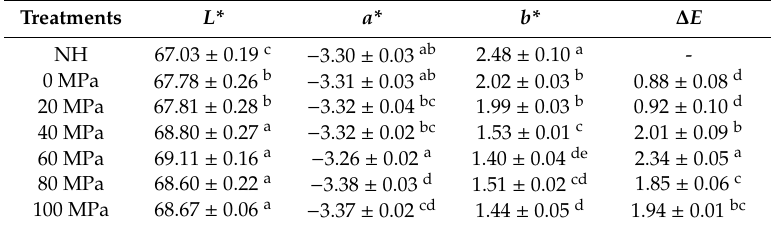
Figure 7. HPH processing decreased the shear stress ( σ ) of the pulps in relation to each shear rate ( γ ). As expected, the lily pulps’ flow behavior was well fitted to the Hershel–Bulkley rheological model ( R 2 > 0.995), and the parameters obtained for this model are summarized in Table 4. The NH and homogenized pulps exhibited pseudoplastic behavior with the presence of yield stress ( σ 0 ). σ 0 is one of the important quality parameters that characterize the properties of semi-solid foods [51]. The σ 0 and consistency index ( k ) of the lily pulps significantly decreased, and the flow behavior index ( n ) increased after HPH processing. Several studies have shown similar product n and k changes in relation to PSD behavior changes. For example, Leite et al. reported that a decrease in particle size caused by HPH promotes a decrease in cashew apple juice consistency, σ 0 , and k and an increase in n [17]. As the homogenization pressure increased from 0 MPa to 100 MPa, the σ 0 value of lily pulp decreased from 0.772 Pa to 0.125 Pa, indicating that the homogenized pulps required low shear stress to initiate the pulp flow. The value of k decreased from 0.088 Pa·s n to 0.012 Pa·s n , suggesting that the viscosity of lily pulp decreased with increasing homogenization pressure at rest. The value of n increased from 0.826 to 0.926, which indicated that the homogenized pulps demonstrated a flow behavior that is close to Newtonian behavior.